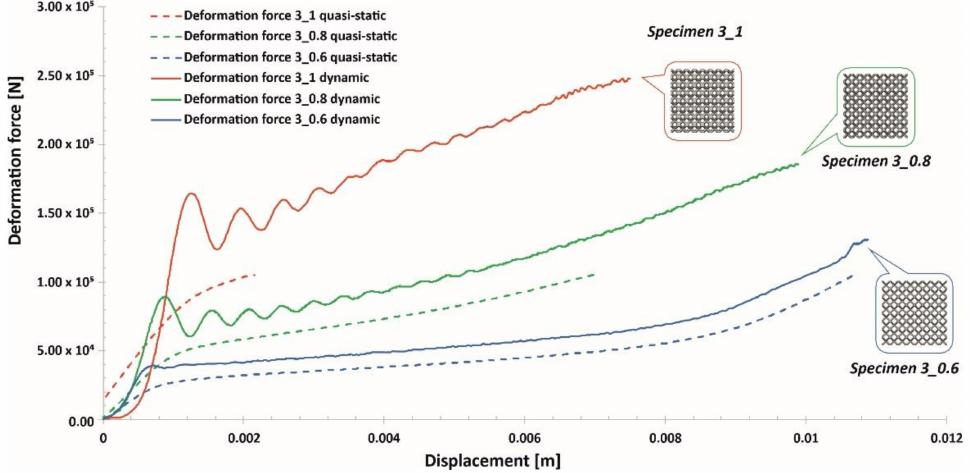
Figure 24. Comparison of the deformation force plots of lattice structure specimens with a 3 mm unit cell size under quasi-static and dynamic loading